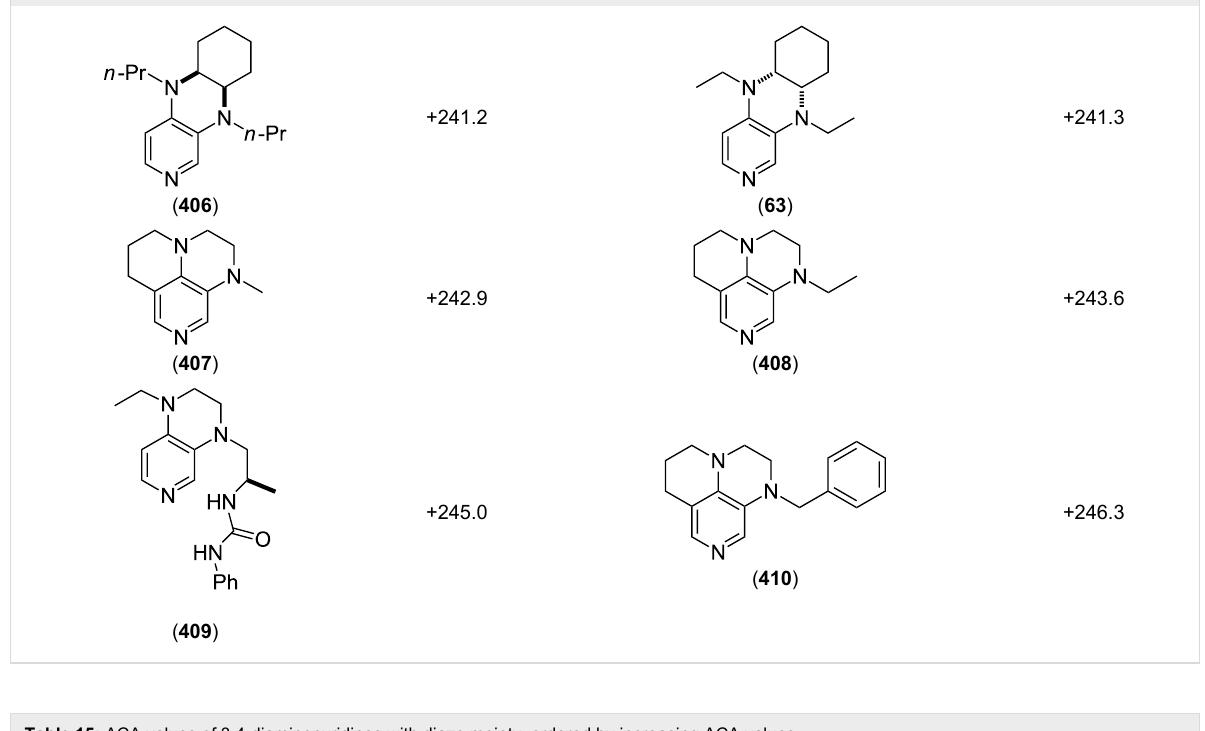
Table 14: ACA values of 3,4-diaminopyridines, ordered by increasing ACA values. (continued)